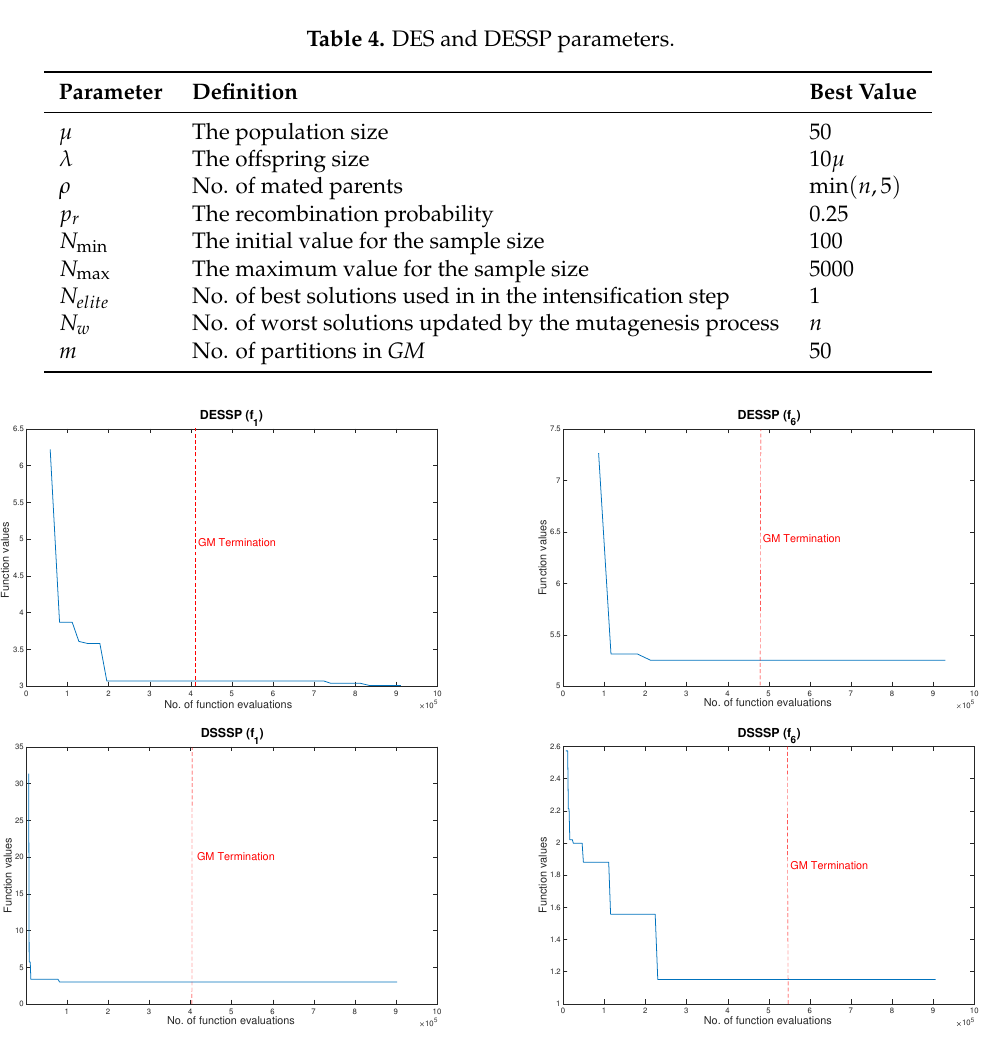
Figure 8. Automatic termination based on the GM